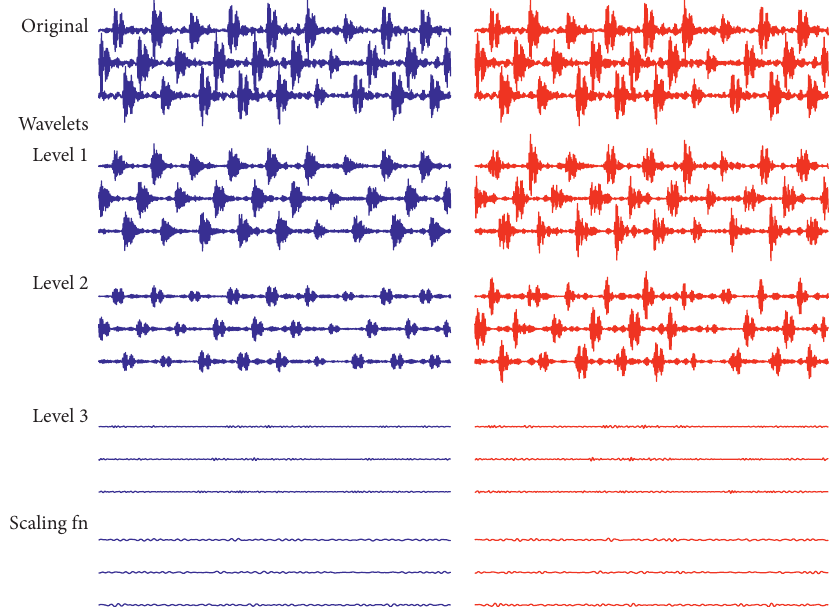
Figure 5: Decomposition results of the original signal and its delay series with dual-tree wavelet (left panel) and Db5 wavelet (right panel).